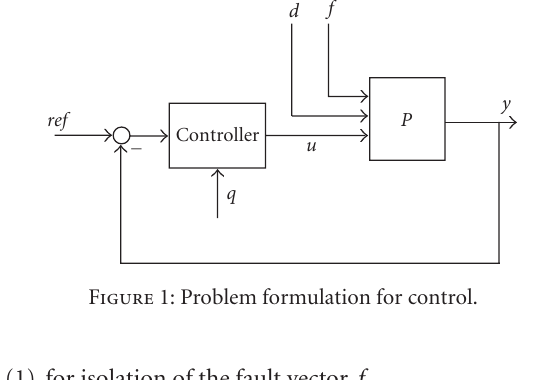
Figure 1: Problem formulation for